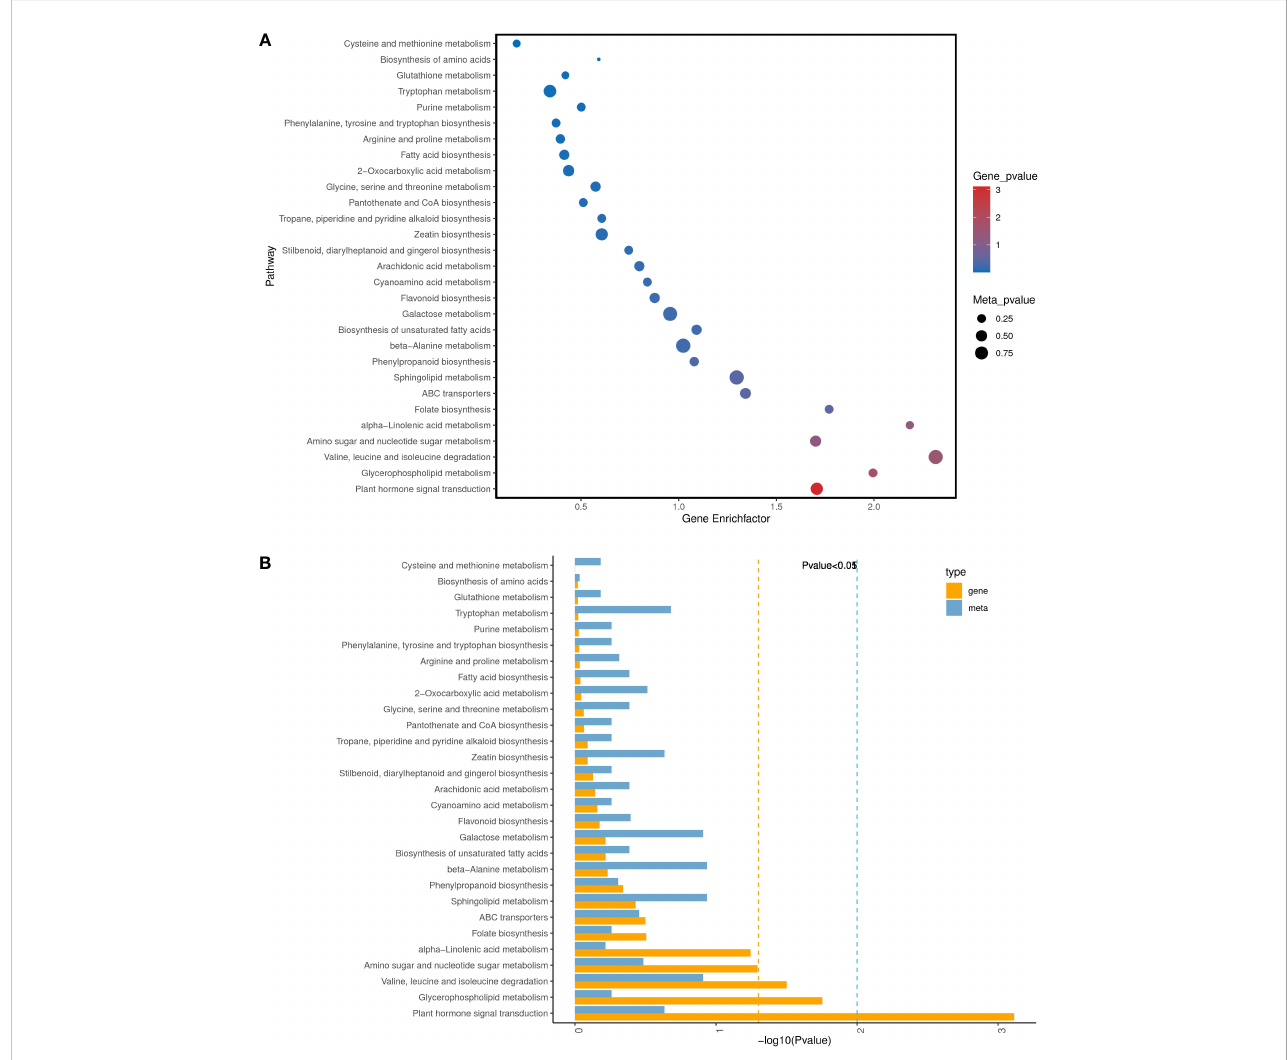
FIGURE 9 Analysis of KEGG pathways signi fi cantly enriched in DEGs/DAMs in K 0 vs. K ck . (A) Bubble diagram of the top 30 KEGG pathways signi fi cantly enriched in DEGs/DAMs. The X-axis represents the Gene Enrich factor, the diff/background of genes in this pathway, and the Y-axis indicates the enrichment pathway. Dot size represents the signi fi cance of enrichment of the annotated DAMs in the pathway; the larger the dot, the more enriched it is. Dot color represents the signi fi cance of enrichment of DEGs in this pathway; the deeper the color, the more enriched they are. (B) Histogram of the top 30 KEGG pathways with signi fi cant enrichment of DEGs/DAMs. Each column represents a KEGG pathway. Yellow represents the transcriptome and blue represents the metabolome. Pathway names are indicated on the Y-axis, and the X- axis indicates the signi fi cance of enrichment of each pathway, that is, the FDR value taking the logarithm of the